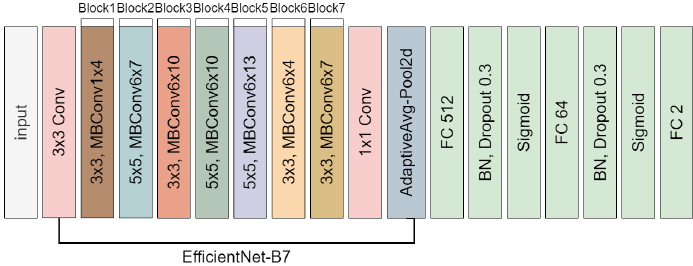
Figure 12. EfficientNet-B7 CNN model for VA classification in